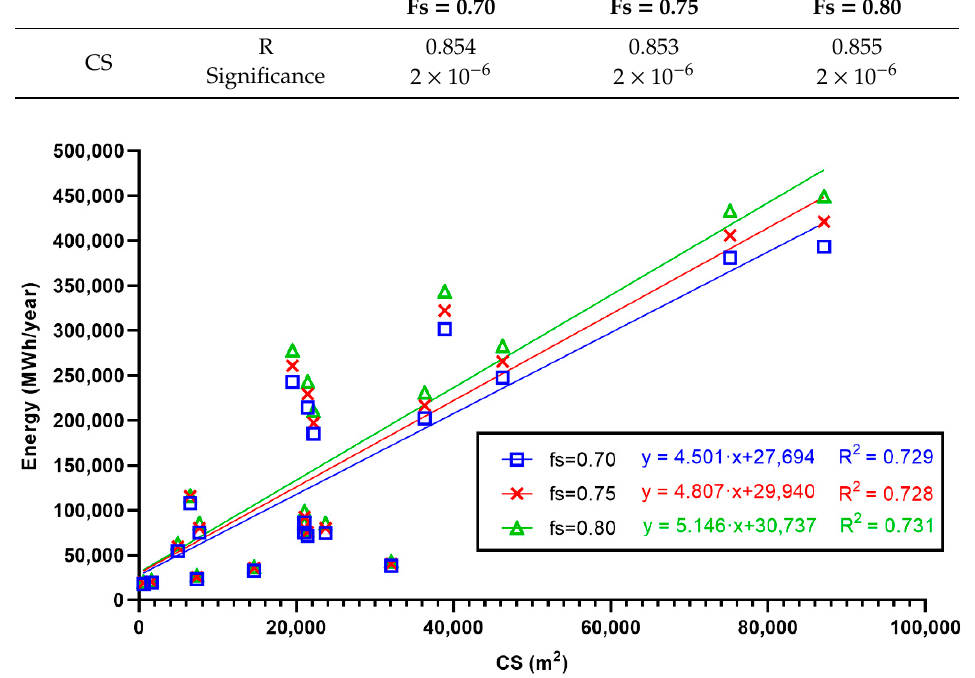
Figure 6. Energy contributed annually by built surface area.